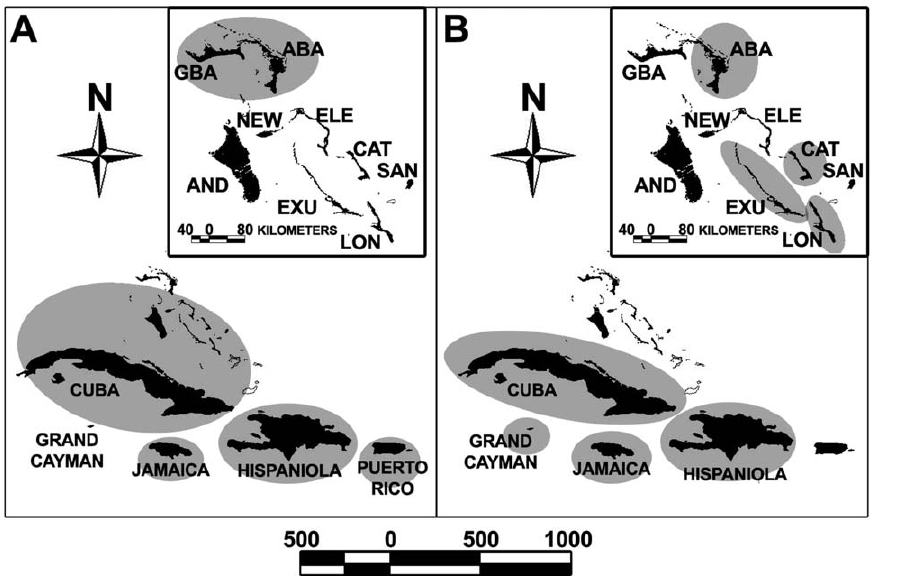
Figure 4. Genetic populations of two lineages of Greater Antillean bats. Erophylla (a) and M. waterhousii (b) as determined by STRUCTURE analysis. Groups for Erophylla are: LBB=Little Bahama Bank, GBB=Great Bahama Bank, JAM=Jamaica, HIS=Hispaniola and PUE=Puerto Rico (see Fig. 1 for island abbreviations). Each island sampled for M. waterhousii represents an independent genetic population.